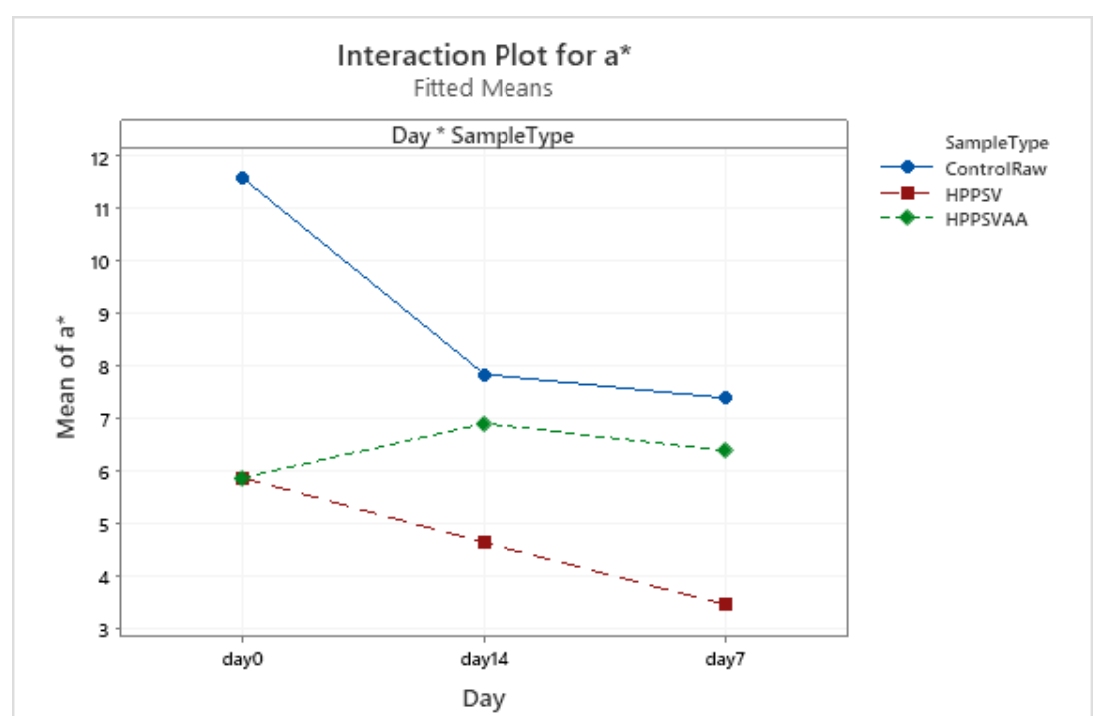
Figure A19. Effect of treatments and storage time on the L * coordinate of hybrid patty (HPPSV: HPP-SVCOOK).